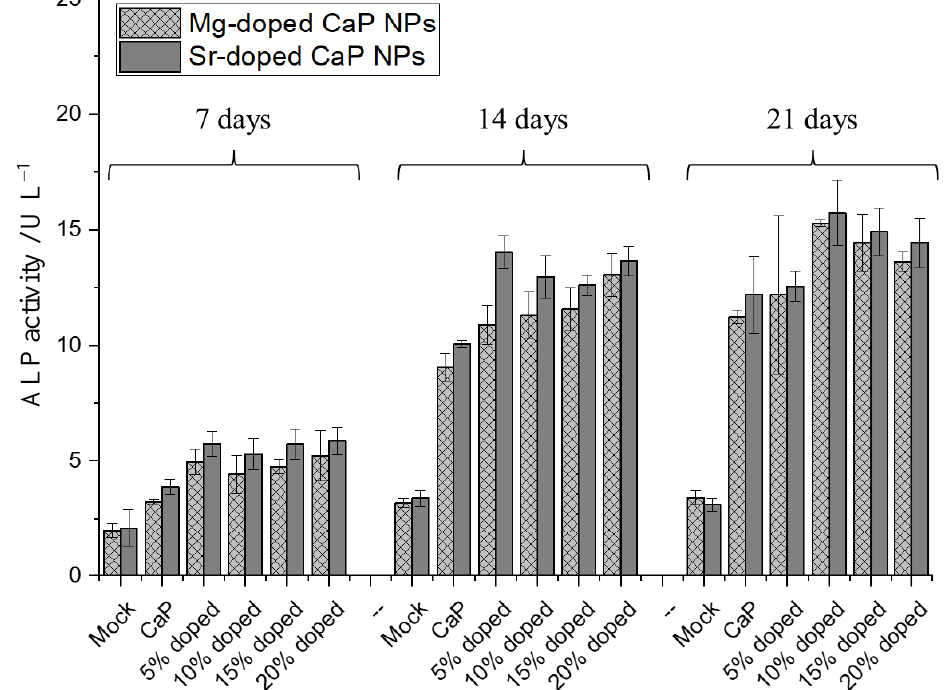
Figure 10. Alkaline phosphatase (ALP) activity in HeLa cells treated with undoped and strontium- or magnesium-doped PEI-functionalized calcium phosphate nanoparticles, normalized to the total protein content, after 7, 14, and 21 days. N = 3 for each data point. Error bars represent standard deviations. Control: untreated cells (mock).